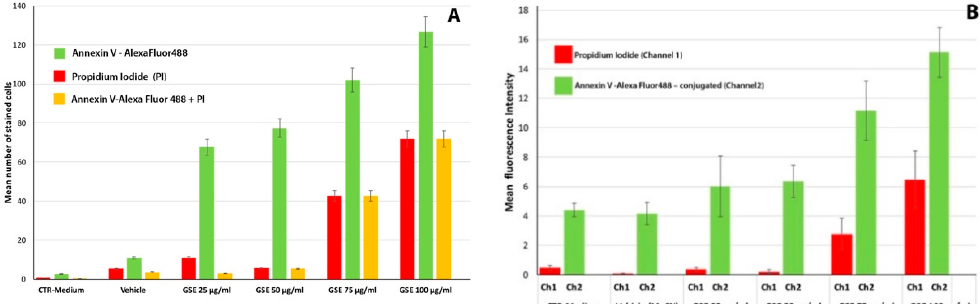
Figure 3. Quantitative analysis of apoptotic MCF-7 cells treated with different doses of GSE and stained with propidium iodide (PI) and Annexin V-Alexa Fluor488–conjugated. ( A ) Mean of stained cells with PI (in red), Annexin V-AlexaFluor488–conjugated (in green) and with both, PI and Annexin V-Alexa Fluor488–conjugated (in yellow) per field; each image captured a field corresponding to 106062.88 µ m × µ m of area (1048576 pixels) and about 209 ± 28 cells. ( B ) Mean intensity of fluorescence detected by the channel 1 (Ch1), corresponding to the PI emission fluorescence, and by channel 2 (Ch2) corresponding to AlexaFluor488 emission fluorescence; the analyses were made on the merged images ( n = 11), 325.35 µ m × 325.35 µ m of area (x:1024, y:1024) with Zen software (Zeiss). Data are mean ± SD.